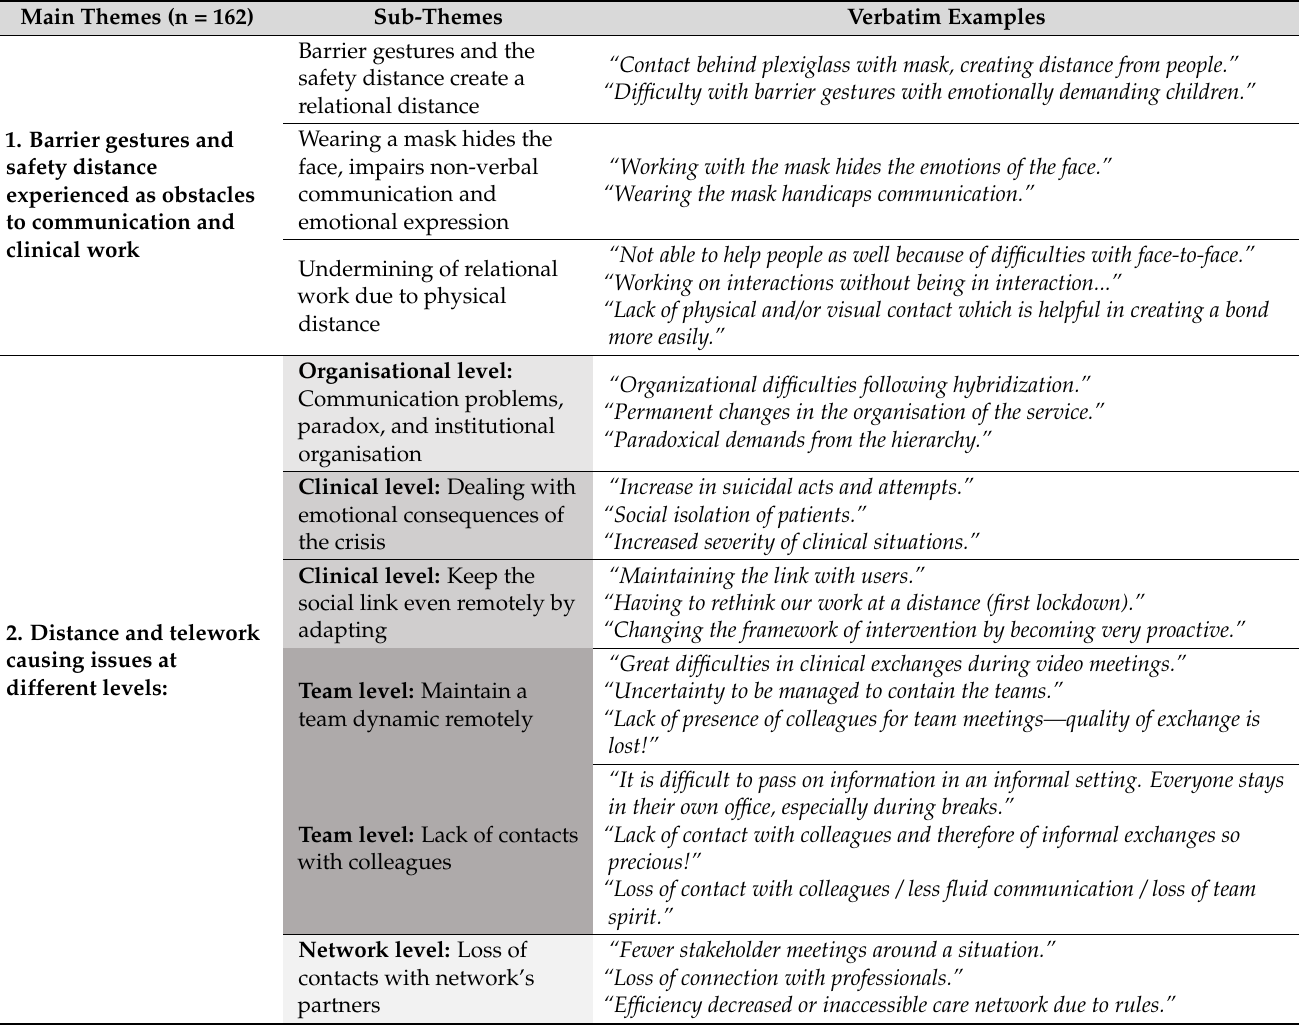
Table 5. Thematic analysis of the first problematic situation described by psychologists in the professional environment for the COVID-19